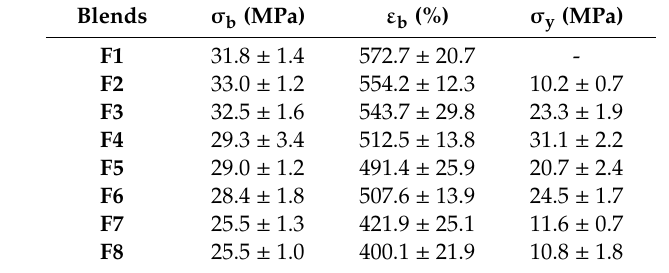
Table 8. Tensile properties of the films obtained from each blend.